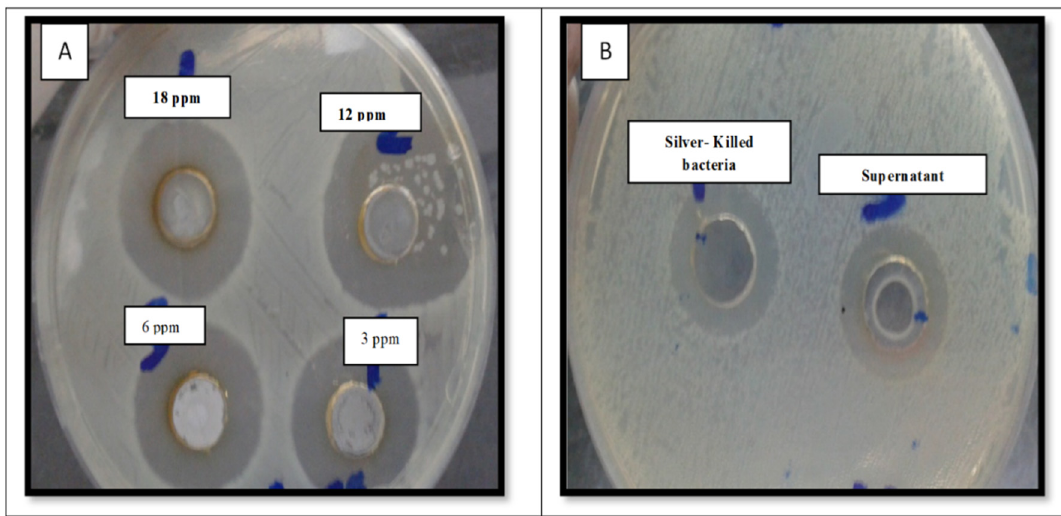
Figure 1. Antimicrobial activity of silver nitrate solution of different concentration ( A ), silver ‐ killed bacteria and supernatant ( B ) against fresh viable E. coli O104:H4 (inhibition zones (25 ± 0.22 mm for pellet suspension and 27 ± 0.41 for supernatant).